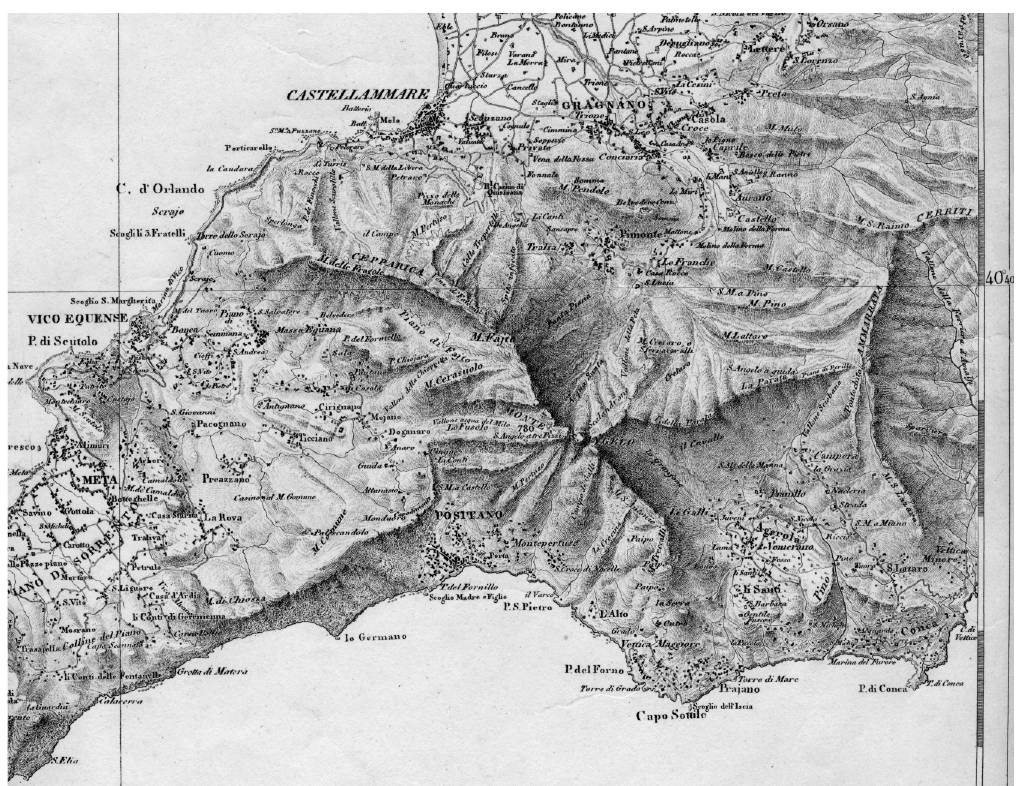
Fig. 5. Detail of the sheet n. 15 of the «Carta dei Contorni di Napoli», scale 1:25000, realized by the Geogra- pher Engeneers Corp of Naples in the years 1817 and 1819 (Private